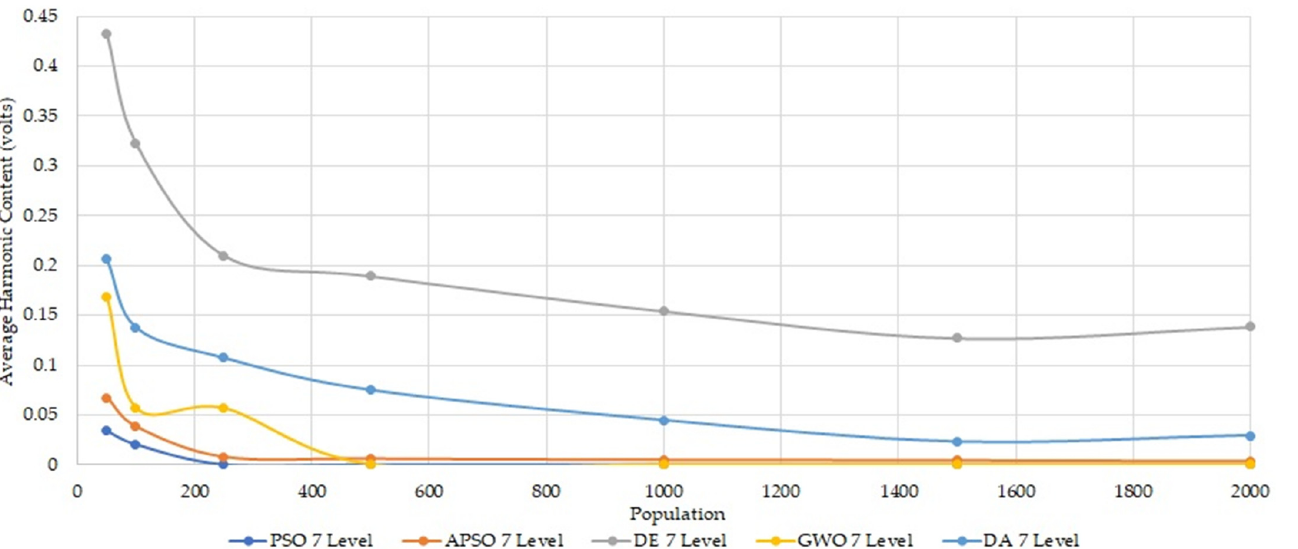
Table 6. Optimized switching angles for eleven-level CHB inverter.